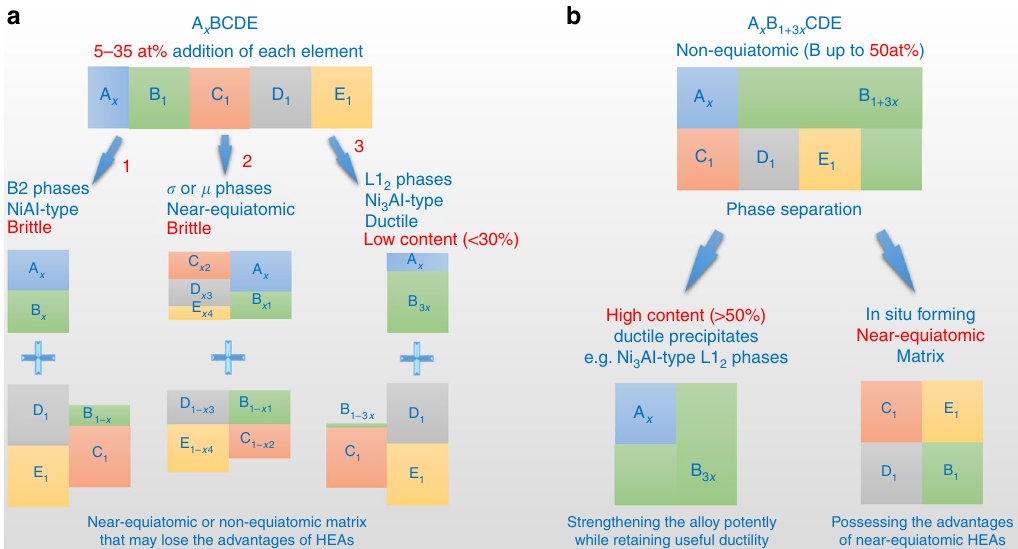
Fig. 1 Comparison between the near-equiatomic alloying concept of HEAs and our strategy. a The near-equiatomic concept hinders the development of stronger and ductile HEAs because (i) near-equiatomic ratios prefer to form brittle phases (generally near-equiatomic, e.g. paths 1 and 2), and (ii) even though decreasing the Al concentrations can increase Ni/Al ratios and obtain ductile L1 2 phases (path 3), near-equiatomic compositions limit the Ni concentrations and hence the L1 2 phase contents. b Our alloying strategy aims to obtain a fi nal microstructure combining a near-equiatomic matrix with high-content ductile precipitates, regardless of the initial atomic